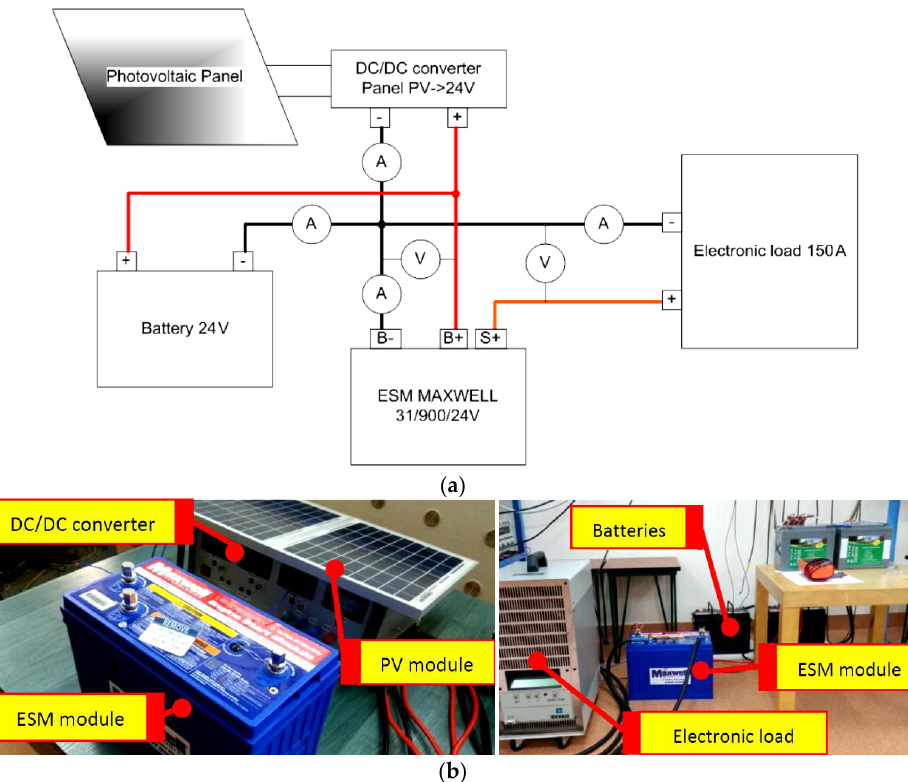
Figure 4. ( a ) The test stand connection diagram, which includes: the ESM module, 24 V battery with electronic load, and a photovoltaic panel; ( b ) photographs of the test stand components. The stand was equipped with: four current sensors for the battery, ESM module, photovoltaic panel, and electronic load; two voltage sensors for the battery and ESM module; and a measurement data acquisition system. The stand was completed with a photovoltaic panel (connected through a step-down DC/DC converter), the purpose of which was to supply electricity to compensate the